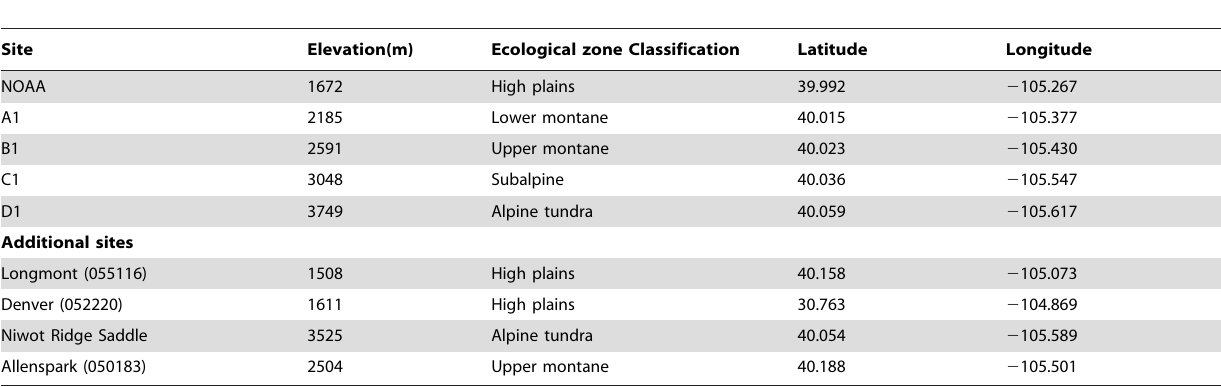
Table 1. Weather stations along the Rocky Mountain Front Range Climate Transect and additional stations used to correct anomalous readings and infill missing climate data.